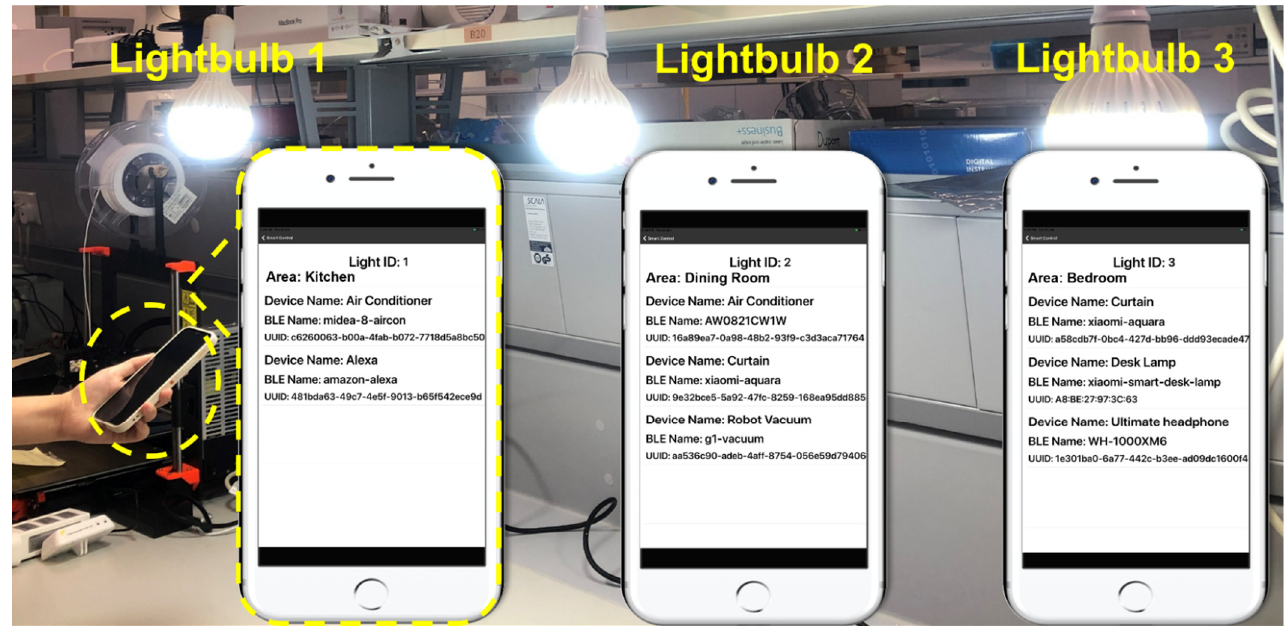
Figure 10. Demonstration of proposed VLC-based smart home control system [17].